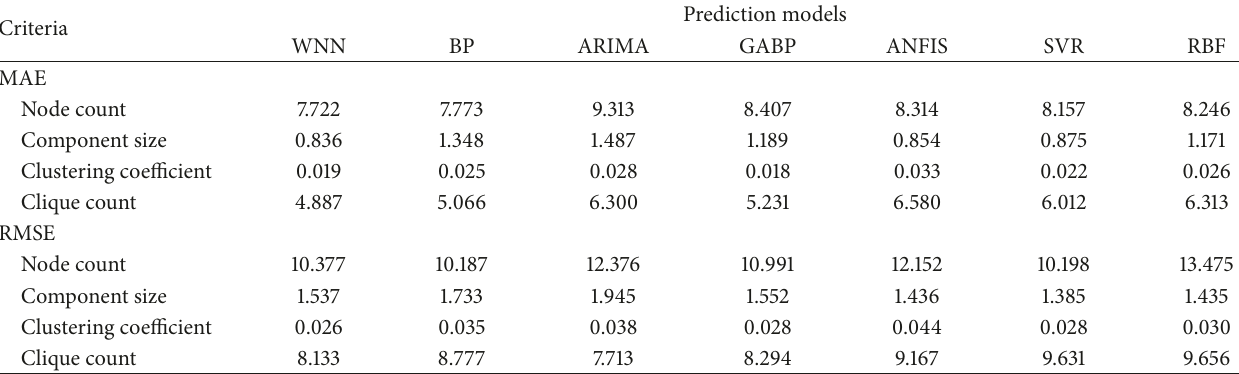
Table 4: Comparison of prediction results of different models.